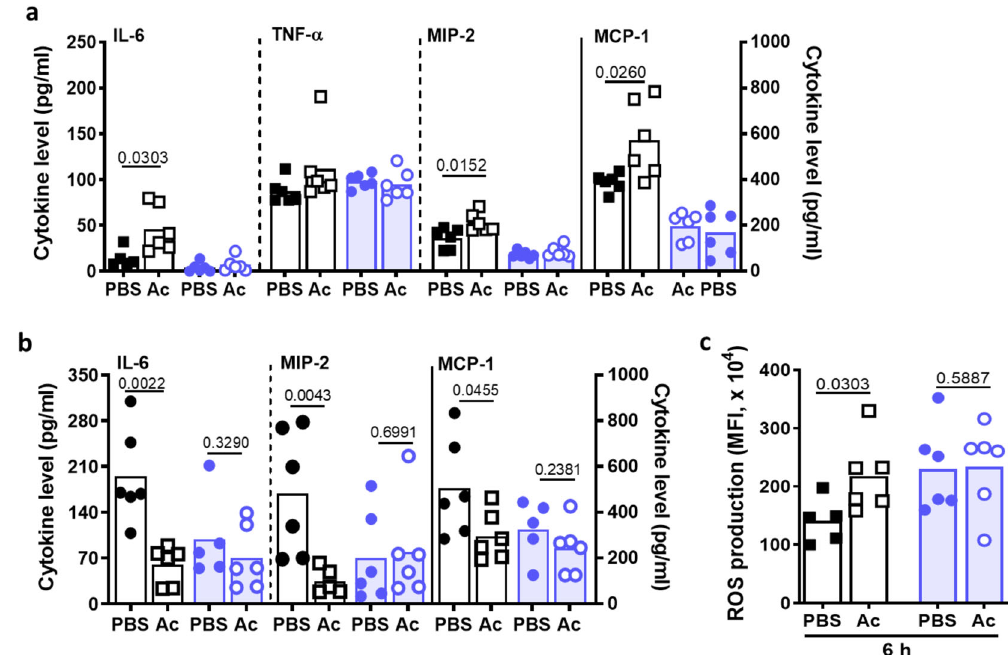
Fig. 6 Intraperitoneal acetate priming promotes cytokine and ROS release during mouse bloodstream infection. a Treatment of wild-type mice (black symbols) with acetate prior to an S. aureus bloodstream infection, i.v. injection induces an initial increase in serum IL-6, MIP-2, and MCP-1 levels measured after 6 h. b This was accompanied by increased intrinsic ROS production by neutrophils from acetate-treated (Ac) wild-type mice, while acetate treatment had no such effect in GPR43 − / − mice (blue symbols). c 48 h after induction of a bloodstream infection, the cytokine levels in acetate-treated (Ac) wild- type but not in GPR43 − / − mice were signi fi cantly decreased compared to PBS-treated mice, which is in line with the decreased disease severity. Data in all panels represent geometric means from six animals. * P < 0.05; ** P < 0.01 signi fi cant difference versus the indicated PBS control as calculated by Mann – Whitney U